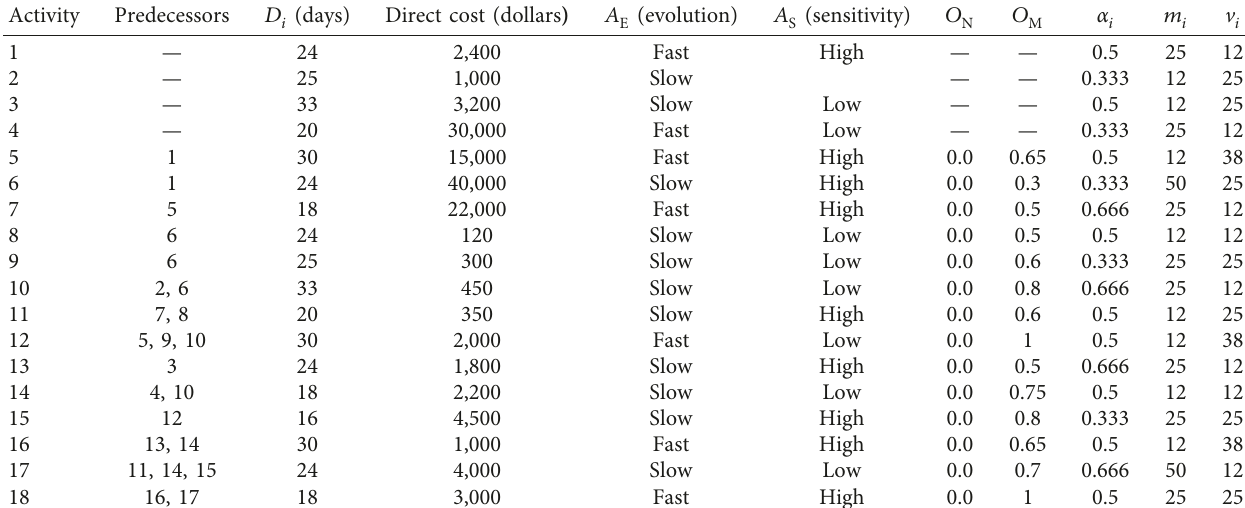
Figure 4: The genes in a random Table 1: Information of activities’ attributes.